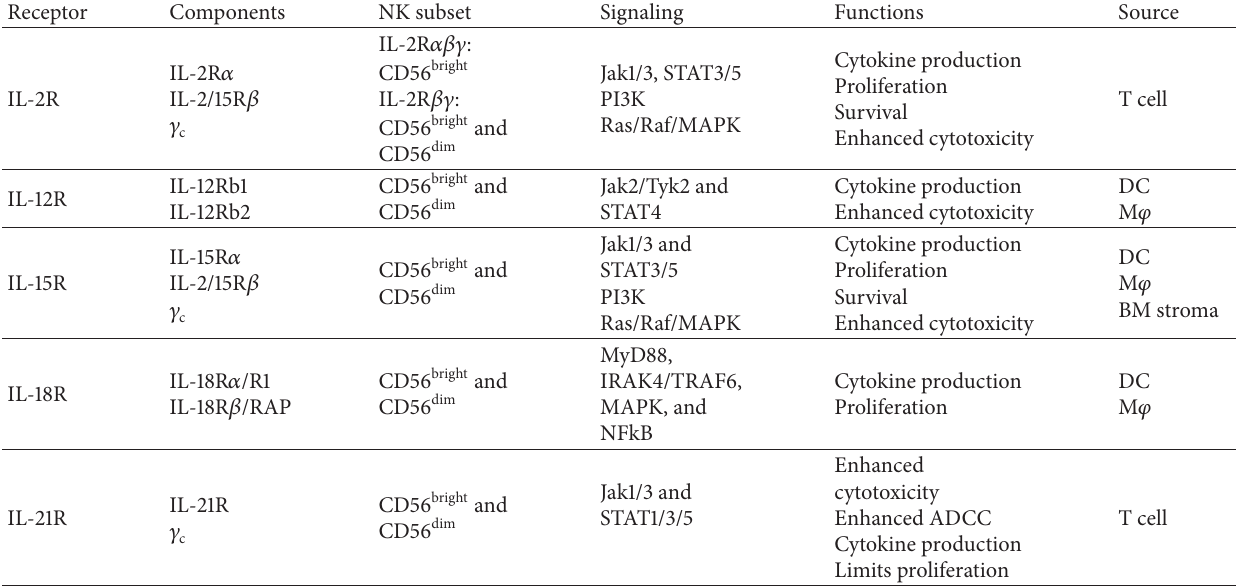
Table 1: Cytokine receptors on human NK